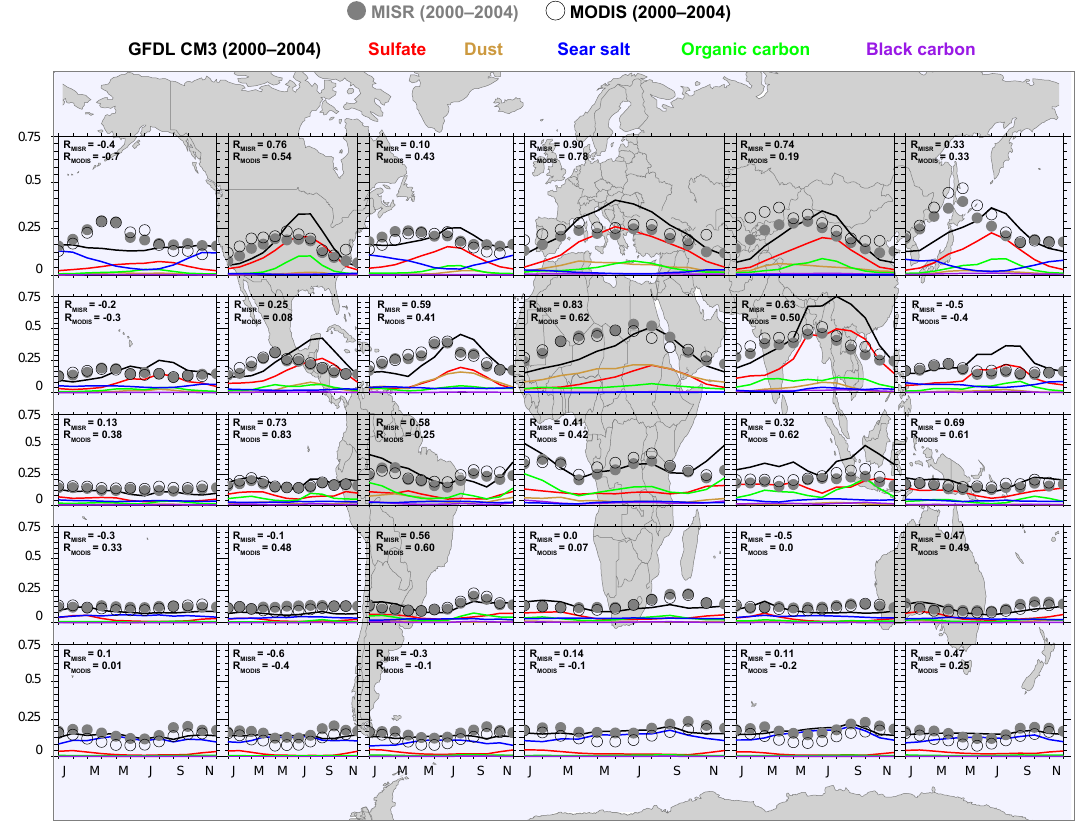
Figure 5. Regional observed and model-derived monthly aerosol optical depth at 550nm. Total CM2.1 AOD (black lines) and individual AODs (sulfate: red, organic carbon: green, black carbon: violet, sea salt: blue, dust: brown) are shown as well. Values are surface-weighted averaged within each panel. Correlations between observed and total simulated AODs are